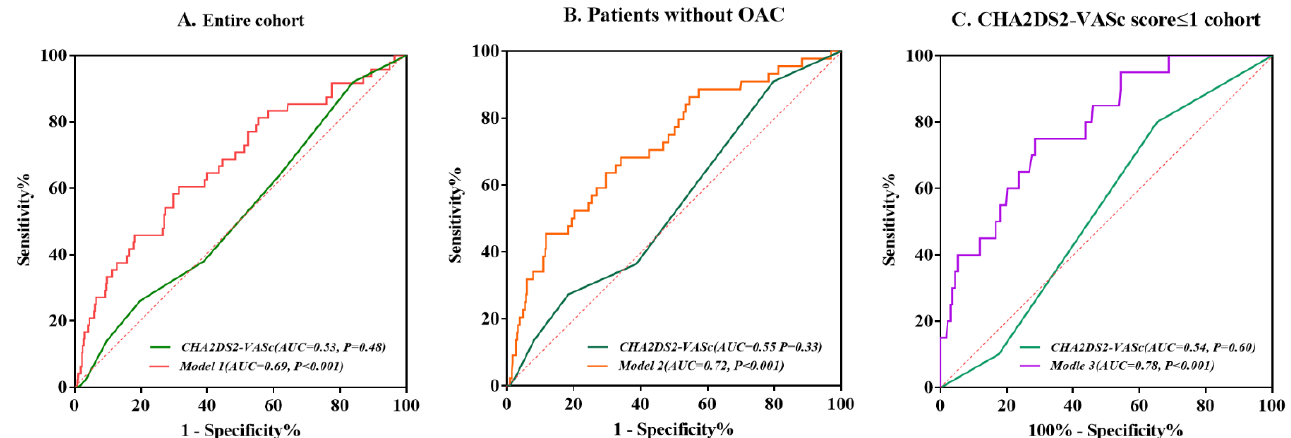
Figure 2. Receiver operating characteristic (ROC) curves for the prediction of LAAT in the entire cohort ( A ) , patients without OAC ( B ) and CHA2DS2-VASc score ≤ 1 cohort ( C ). Model 1: CHA2D2S2-VASc score incorporated with NT-proBNP and LDL-C for entire cohort; Model 2: CHA2D2S2-VASc score incorporated with NT-proBNP and LDL-C for patients without OAC; Model 3: CHA2D2S2-VASc score incorporated with LDL-C for CHA2DS2-VASc score ≤ 1 cohort.